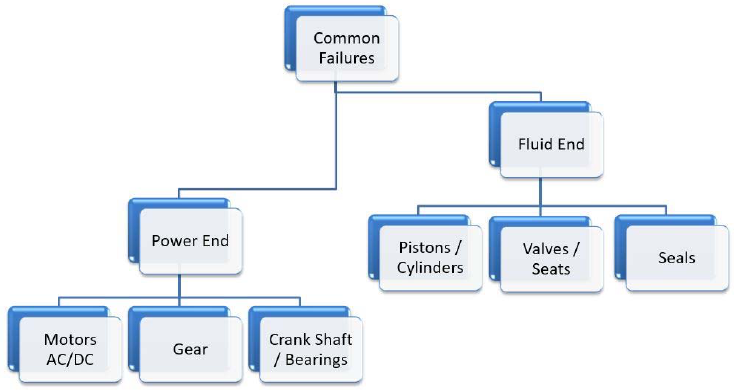
Figure 7. A new valve head ( left ) and damaged seat and head of a mud pump valve ( right ) [4,6].